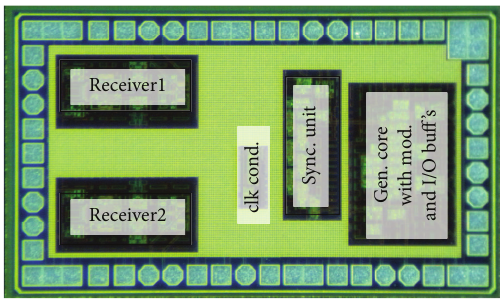
Figure 2: Single chip UWB